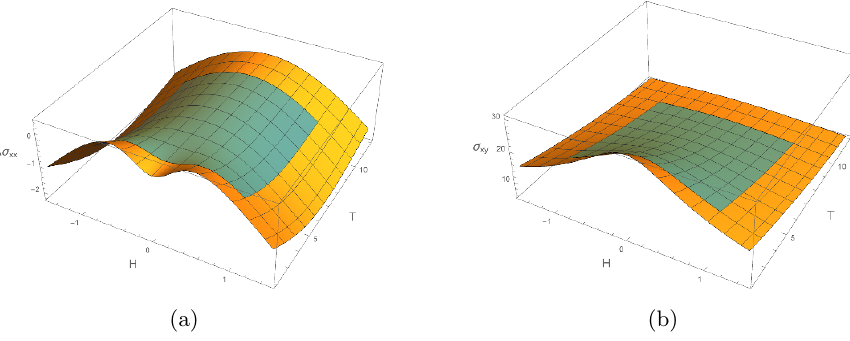
Figure 19 . The temperature and the magnetic (cid:12)eld dependence of (a) parallel, (b) transverse magnetoconductivity. In this subsection we used v F = c= 3000 ; (cid:12) = 1 : 82 ; q (cid:31) (cid:13) = 5 : 6 in all the (cid:12)gures. The green colored island corresponds to the region where it is expected that our theory might be valid.